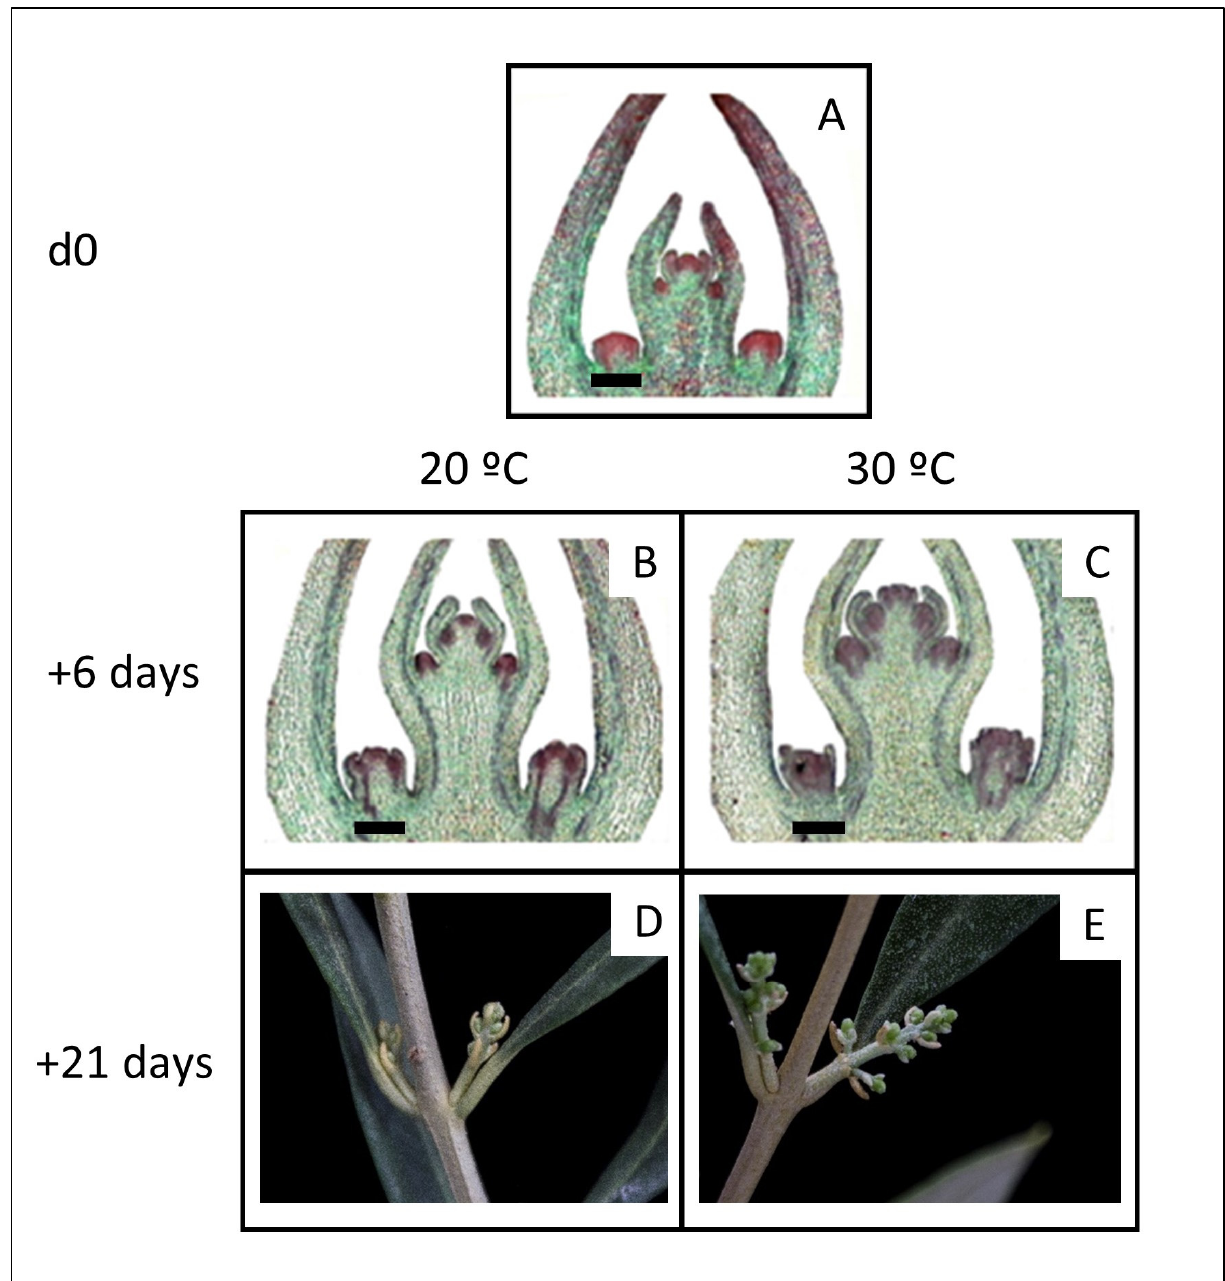
Figure 4. Growth and differentiation of buds sampled 11 February (d0), and after 6 and 21 days of forcing at 20 °C or 30 °C. ( A – C ) show central longitudinal histological sections of individual buds, while ( D , E ) are photographs of young inflorescences, each developing from one of the two axillary buds at the node. In the histological preparations, reproductive differentiation of the buds is apparent in the darkly staining axillary structures of the buds, particularly within the first, most external pair of bud leaf primordia. Staining described in Section 4.1.2. Bar = 200 µ